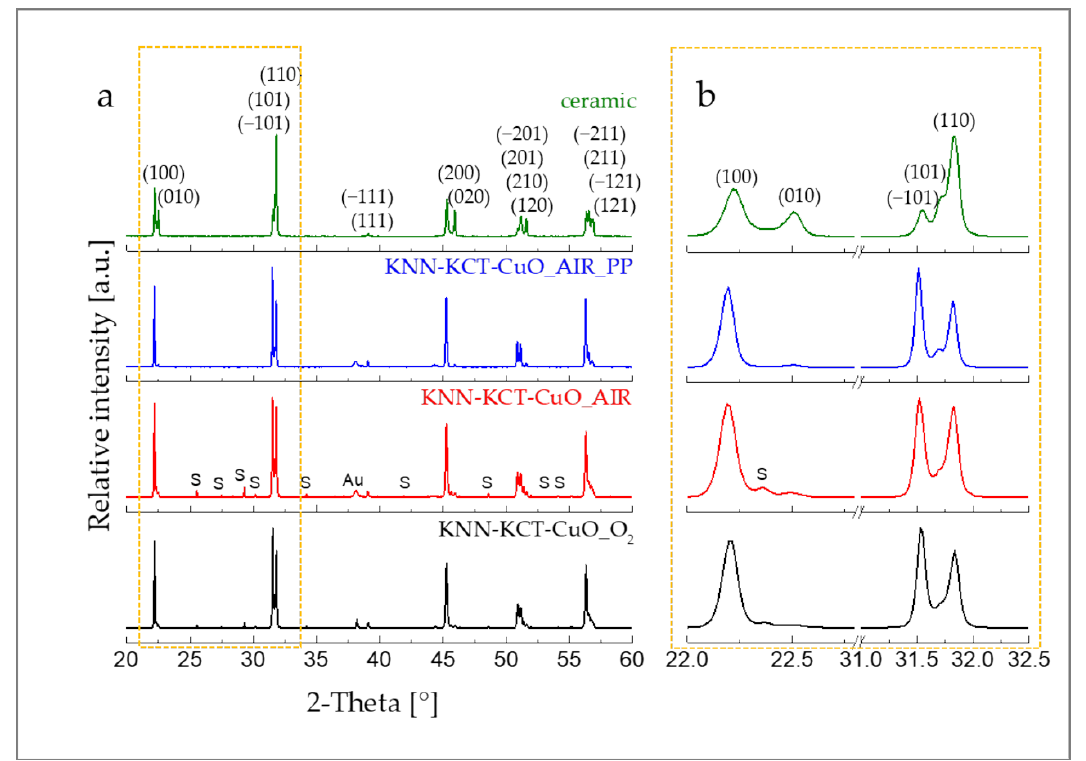
Figure 1. ( a ) XRD patterns of KNN-KCT-CuO thick films sintered at 1100 °C for 2 h in oxygen or in air with and without the packing powder (PP) and KNN-KCT-CuO ceramic sintered at 1000 °C for 2h in air; ( b ) enlarged view of {100} and {110} peaks of the perovskite phase in 2-theta range 22 – 22.8° and 31 – 32.5°; (hkl): perovskite phase, S: secondary phase, Au: top gold electrode. Indexing of the perovskite phase is according to the monoclinic unit cell (PDF 61-0319, [28]).